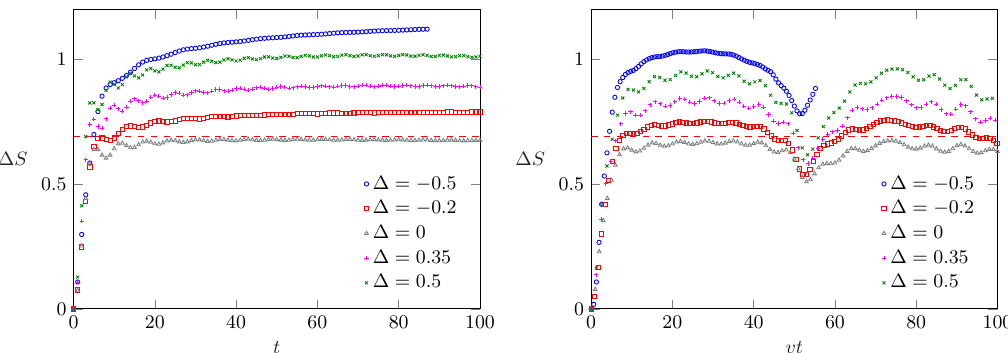
Figure 3: Left: Entropy growth in the middle of the chain r = 0, after the Majorana excitation m for different values of ∆ and L = 200. The red dashed line indicates 1 the value ln ( 2 ) . Right: ∆ S for a smaller chain with L = 50 against the scaled time vt for the same ∆